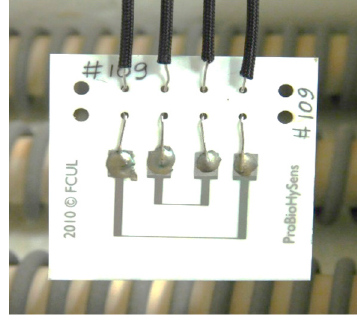
Figure 6. Transient hot-strip sensor for high temperature thermal conductivity measurement. The sensor is composed by a metallic thin Platinum film, deposited by PVD on an alumina substrate. The hot strip lengths are l L = 15 mm, l S = 5 mm, and thickness w = 110 µm [49].